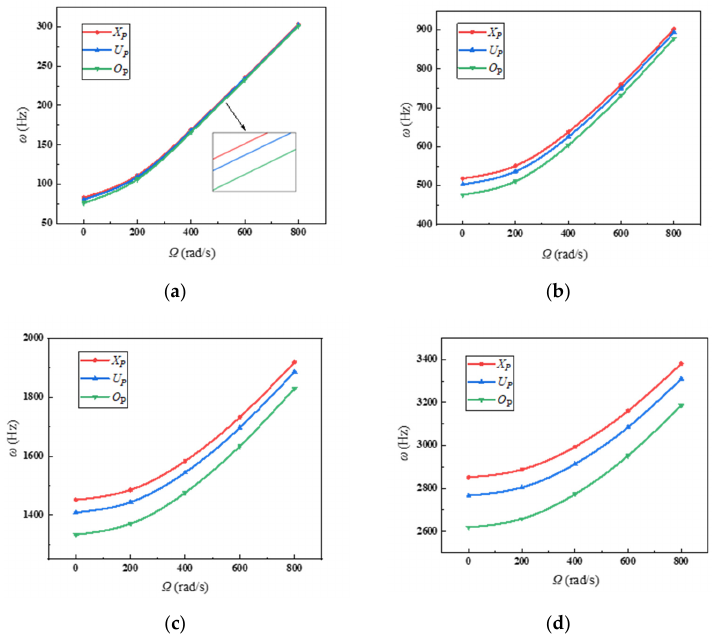
Figure 9. Variations of frequencies with rotating speed under different GPL distribution patterns. ( a ) First frequency; ( b ) second frequency; ( c ) third frequency; ( d ) fourth frequency.